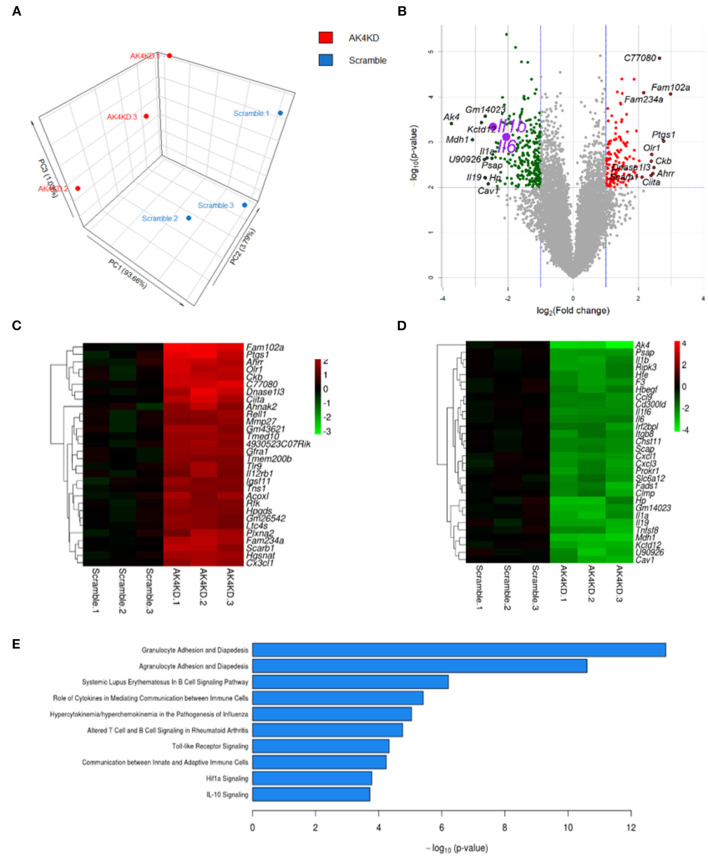
Ak4-regulated pathways in Ak4 shRNA-treated M1 cells were revealed by next generation sequencing. (A) Principal component analysis (PCA) of Ak4-regulated genes. PCA was plotted using expression of differentially expressed genes after Trimmed mean of M-values (TMM) normalization. Each dot represents one sample. Three independent experiments were performed for both Ak4 shRNA group (red) and scramble control (blue). (B) Volcano plots of differentially expressed genes in Ak4 shRNA-treated M1 macrophages. Criteria for selecting Ak4-regulated genes: fold change >2X or <1/2X and P < 0.001. Red points: up-regulated genes in Ak4 shRNA-treated M1 macrophages; green points: down-regulated genes in Ak4 shRNA-treated M1 macrophages. (C) Heat map and hierarchical cluster analysis of top 30 up-regulated genes in Ak4 shRNA-treated M1 macrophages. Red: up-regulated genes as compared to scramble shRNA control. (D) Heat map and hierarchical cluster analysis of top 30 down-regulated genes in Ak4 shRNA-treated M1 macrophages. Green: down-regulated genes as compared to scramble shRNA control. (E) Canonical pathways of Ak4-regulated genes using Ingenuity Pathway Analysis (IPA).